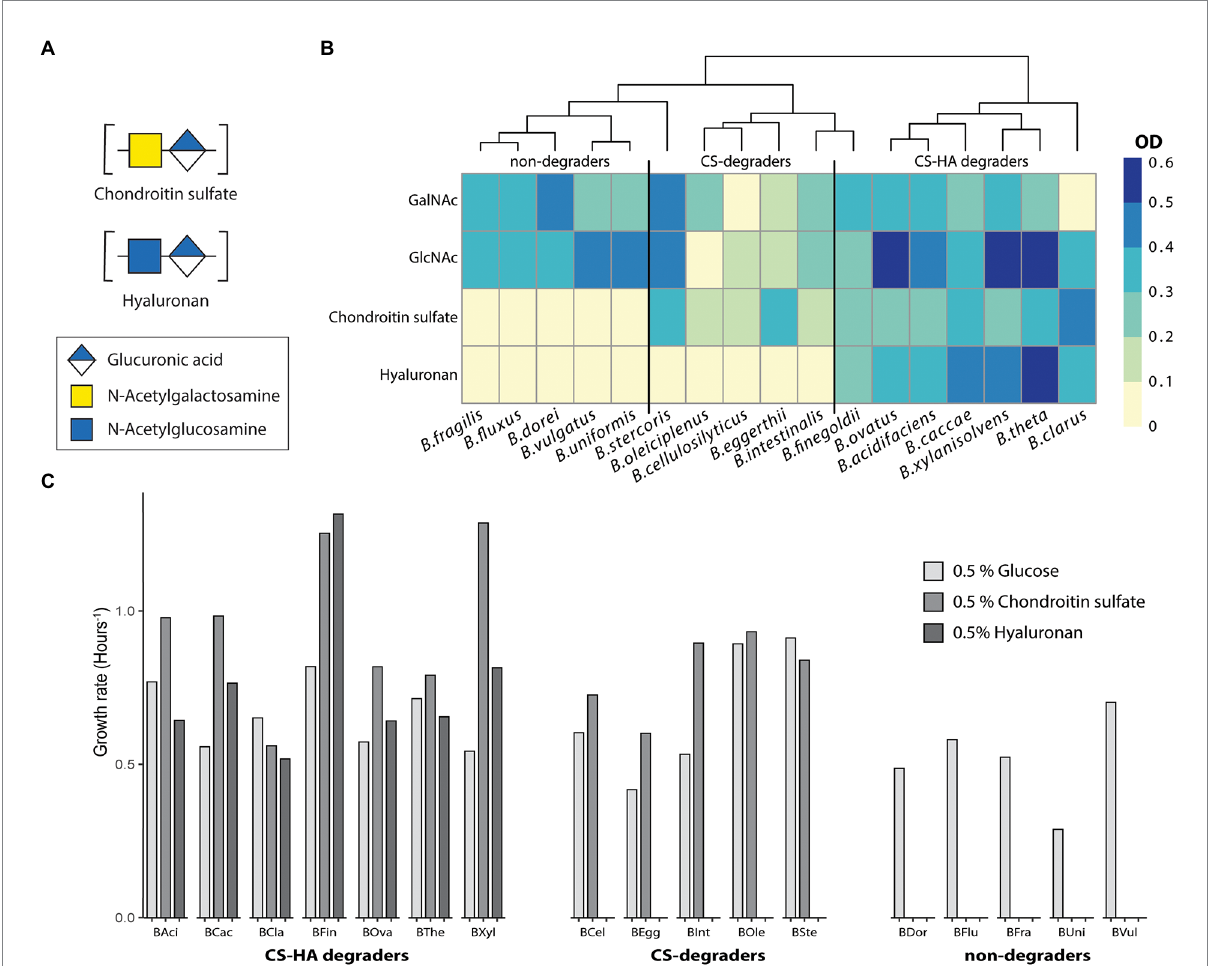
FIGURE 1 Not all strains capable of degrading CS can also degrade HA. Growth metrics for 17 Bacteroides species on 0.5% of glucose, chondroitin sulfate (CS) or hyaluronan (HA). All growth was performed in triplicates with at least two biological replicates. (A) Average final optical density (OD 600 ) at 19 h for 17 Bacteroides strains. Almost all species can degrade GalNAc and GlcNAc whereas there are distinct groups for those which can degrade both chondroitin sulfate (CS) and hyaluronan (HA), CS-only or neither. OD < 0.1 was considered to be no growth. (B,C) Growth rate (hours − 1 ) measured from the exponential part of the growth curve. BAci, B . acidifaciens ; BCac, B . caccae ; BCel, B . cellulosilyticus ; BCla, B . clarus ; BDor, B . dorei ; BEgg, B . eggerthii ; BFin, B . finegoldii ; BFlux, B . fluxus ; BFra, B . fragilis ; BInt, B . intestinalis ; Bole, B . oleiciplenus ; BOva, B . ovatus ; BSte, B . stercoris ; BThe, B . thetaiotaomicron ; BUni, B . uniformis ; BVul, B . vulgatus ; BXyl, B . xylanisolvens